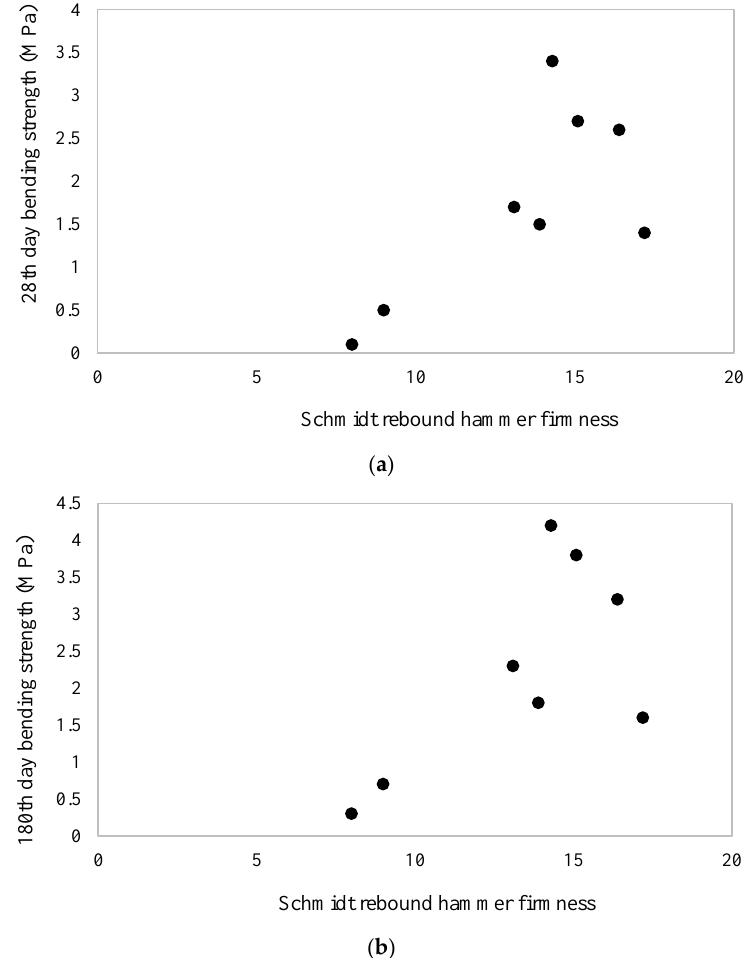
Figure 10. Strong regression relationship between bending strength and Schmidt surface hardness on ( a ) the 28th day and ( b ) the 180th day.